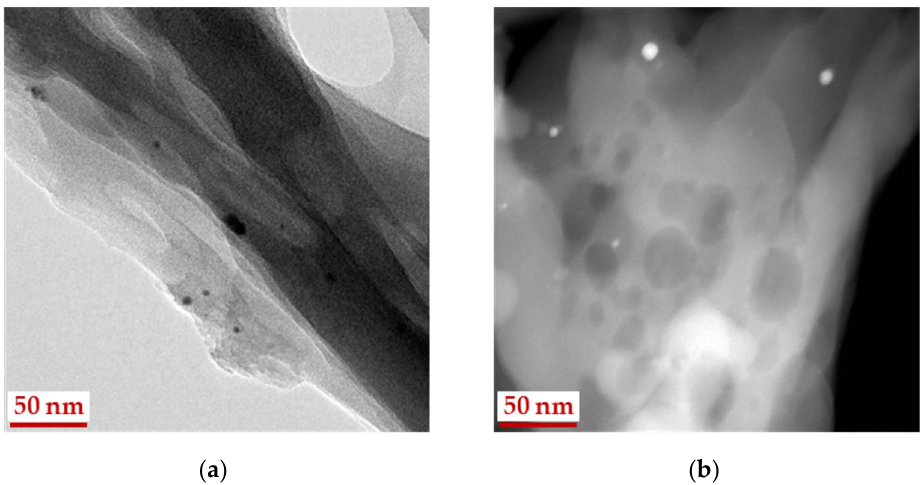
Figure 4. HRTEM images of silver particles in Ag-AC composite aerogel prepared from Ag-MCC, in bright ( a ) and dark ( b ) fields.